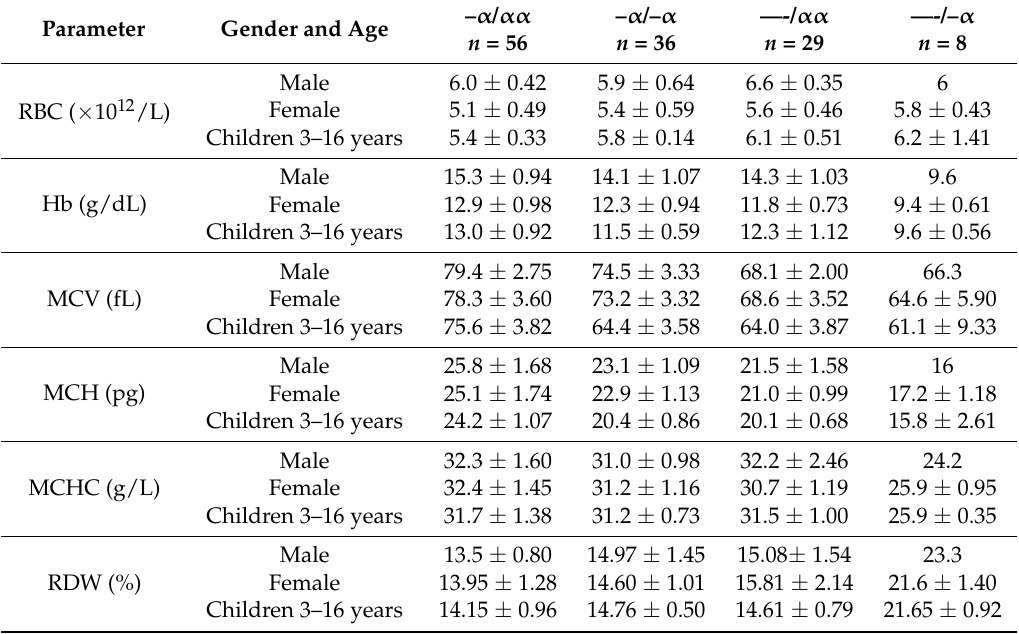
Table 1. Hematologic parameters of the different subtypes of deletional α -thalassemia. Data represent mean ± SD (standard deviation).